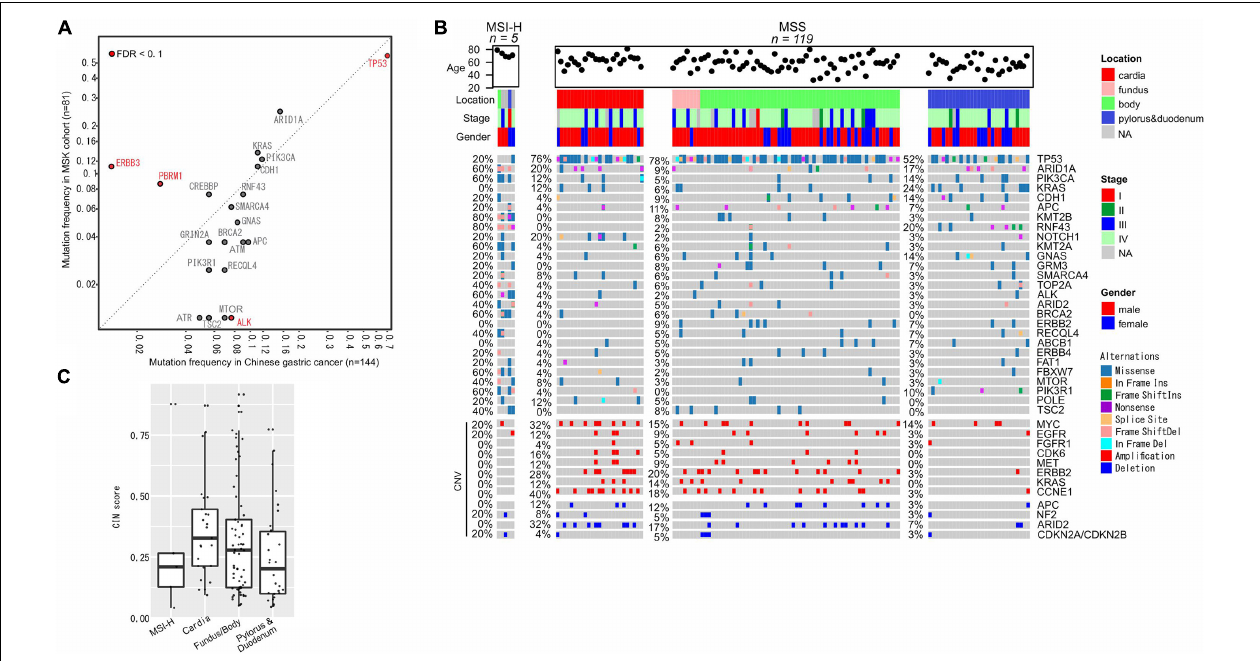
FIGURE 5 | Molecular characterization of gastric cancer. (A) Mutation frequency comparisons between our cohort and the MSKCC gastric cancer cohort. (B) Gene alterations in the sub-groups of colorectal cancers. (C) CIN status in different